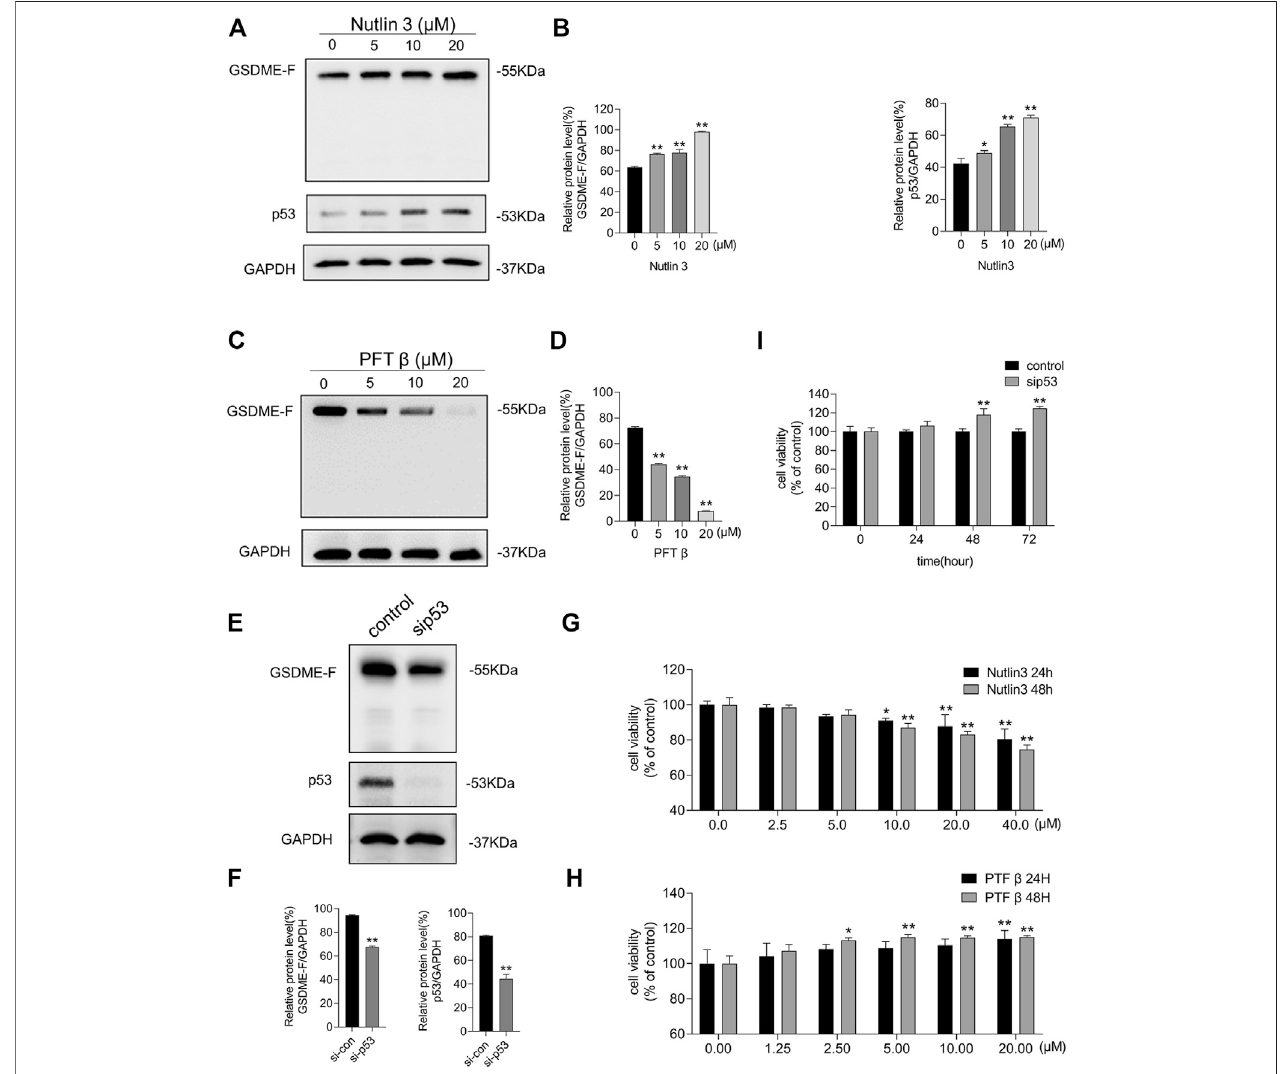
FIGURE 4 | The expression of GSDME was mediated by p53 activity. (A) Western blot was conducted to display the expression of GSDME, p53, and GAPDH in MCF-7 cells treated with nutlin-3 for 48 h. (B) Quantity of GSDME and p53 in (A) . (C) Western blot was conducted to display the expression of GSDME and GAPDH in MCF-7 cells treated with PFT β for 48 h. (D) Quantity of GSDME in (C) . (E) Western blot was utilized to con fi rm the knockdown effect of p53 siRNA in MCF-7 cells. (F) Quantity of GSDME and p53 in MCF-7 cells after p53 siRNA transfection. (G) The CCK8 assay was used to measure the cell viability of MCF-7 cells treated with nutlin-3 for 24 and 48 h. (H) The CCK8 assay was used to measure the cell viability of MCF-7 cells treated with PFT β for 24 and 48 h. (I) MCF-7 cell viability with p53 siRNA transfection was detected by the CCK8 assay. Statistically signi fi cant: * p < 0.05; ** p < 0.01.